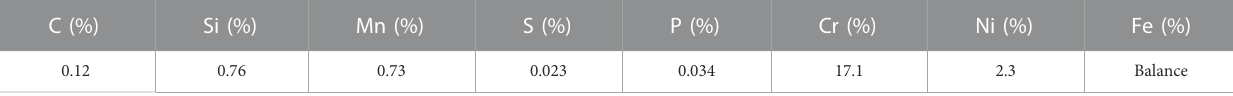
TABLE 1 Element weight percentage of the 1Cr17Ni2 stainless steel blade